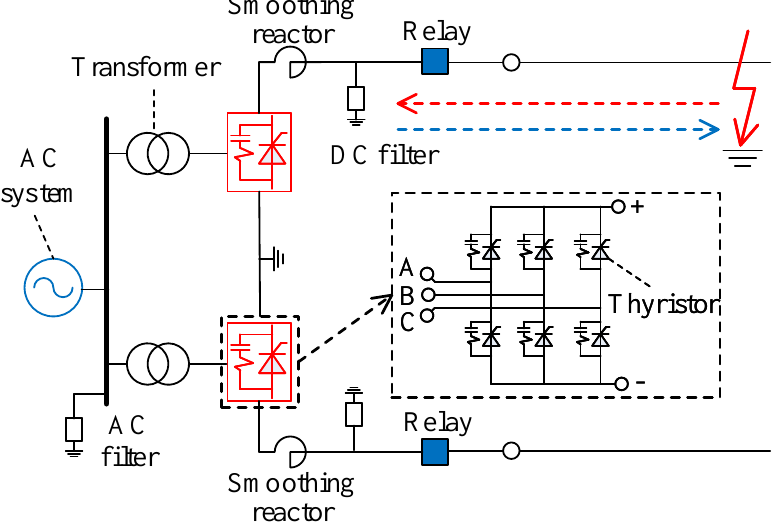
Figure 2. Typical structure of LCC-HVDC rectifier